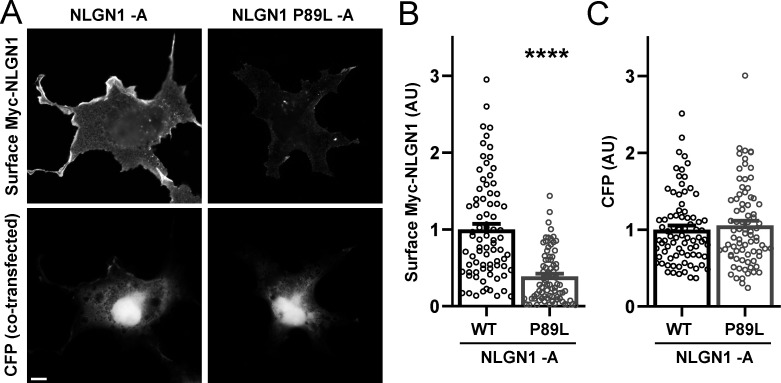
The NLGN1 P89L mutation reduces surface expression.COS7 cells were co-transfected with expression vectors for CFP and for Myc-NLGN1 -A (WT) or Myc-NLGN1 P89L -A. After 48 hr, cells were fixed without permeabilization and immunolabelled for surface Myc. Cells were chosen for imaging only by CFP expression. Myc-NLGN1 P89L -A showed reduced surface expression relative to WT, ****p<0.0001 by Mann-Whitney test, n = 80 cells from two independent experiments. Scale bar, 10 µm.